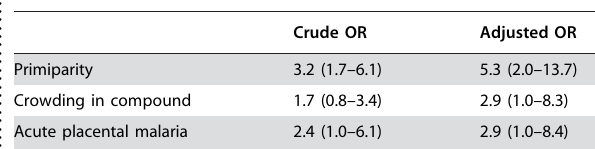
Table 2. Independent risk factors (OR, 95% CI) for congenital